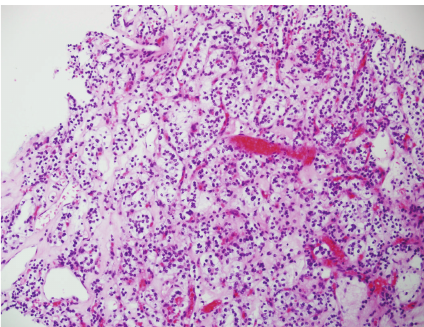
Figure 1: High power of biopsy showing area consistent with clear cell renal cell